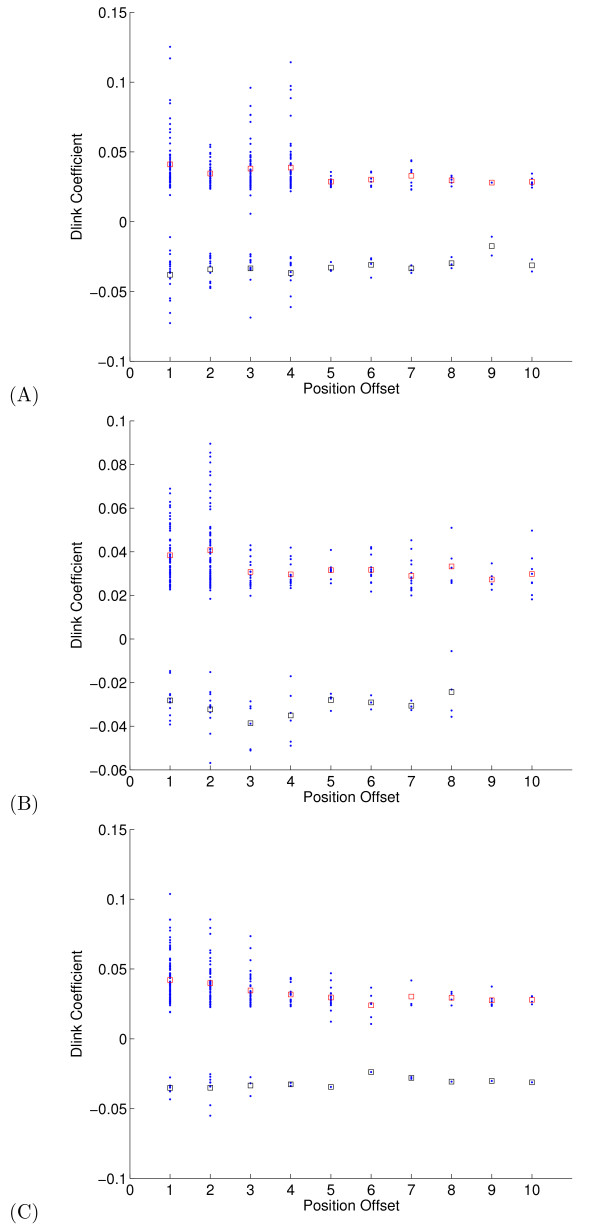
The relationship between model parameters and secondary structure element types. (A) The figure plots, for helices, the learned non-zero dlink parameters at the 90% sparsity level as a function of the offset from the current amino acid. The mean of positive (red squares) and negative values (black squares) are displayed separately. (B)-(C) The figures show similar plots for β strands and loops, respectively. Certain positions retain more dlink parameters than the others demonstrating the correlation behavior between a given position and its local neighbors.